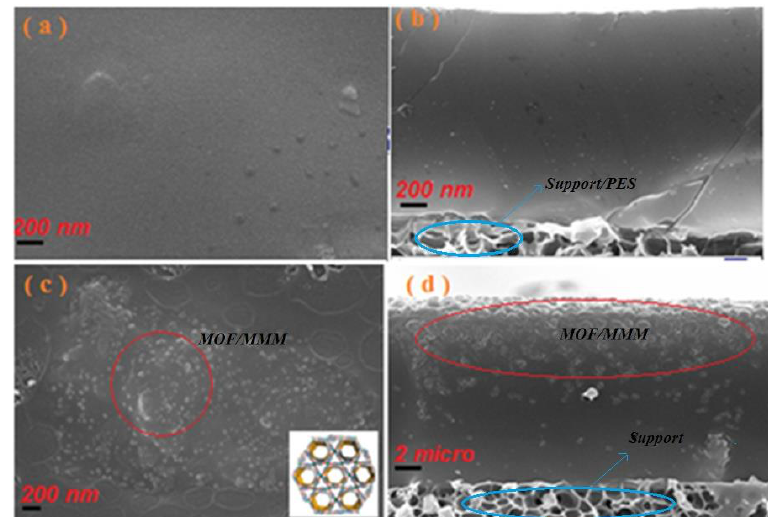
Fig. 6. SEM image of a) surface of PDMS/PES, b) cross section of PDMS/PES, c) surface MMM with 20wt% of nano Dy-BTC, d) Cross section of MMM with 20wt% of nano Dy-BTC.